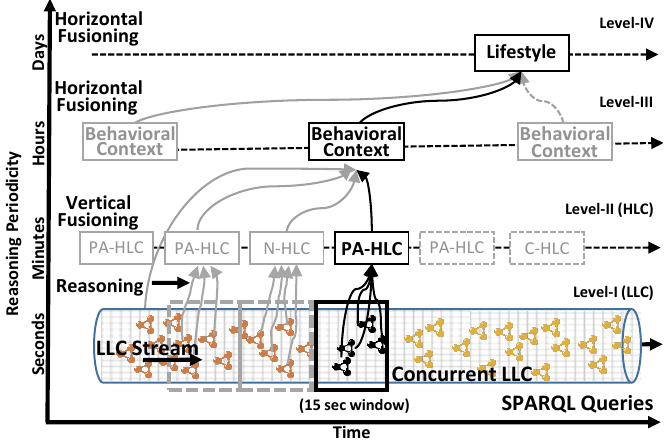
Figure 5. Exemplification of representation for mlCAF at different abstraction levels using Vertical and Horizontal